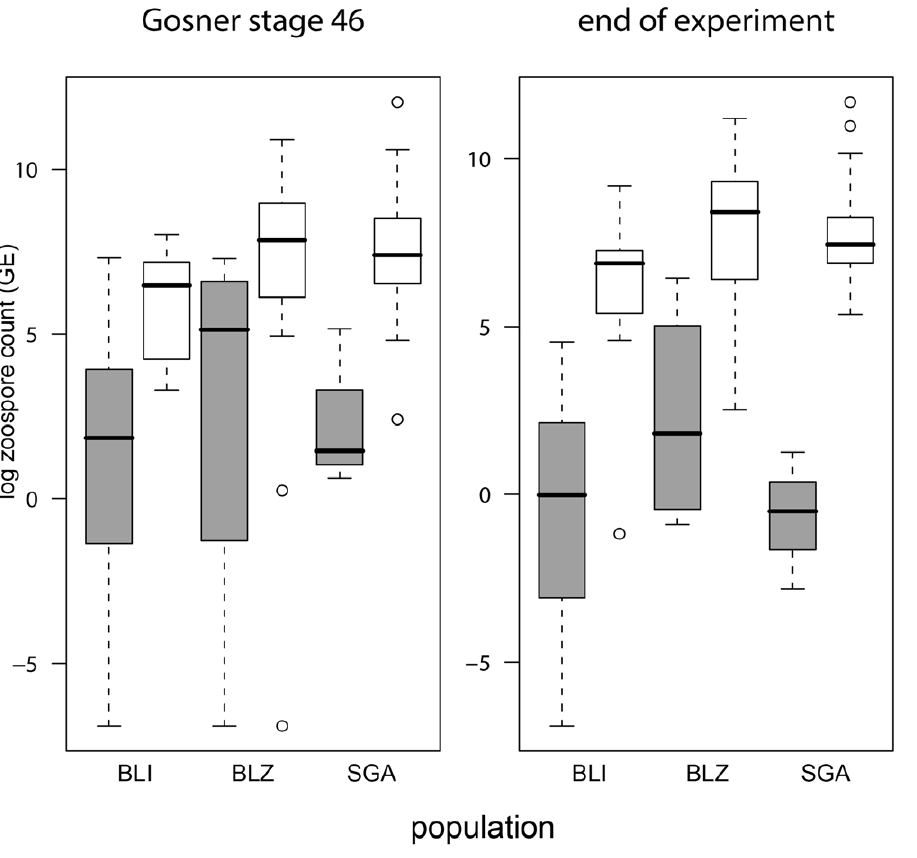
Figure 4. Infection loads of surviving and non-surviving individuals. Infection load, measured in genomic equivalents from rt-PCR reactions and logarithmically transformed, in individuals from the infected treatments at the end of experiment. The black line represents the median, the box represents the interquartile range containing 50% of the values, and whiskers mark the 1.5 fold interquartile range. Outliers are marked with circles. Grey boxes=survivors, white boxes=non-survivors.